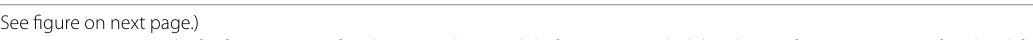
figure on next Fig. 4 Estimation results for four stages. Left column: median model of posterior probability density functions (PDFs) of each subfault. Inserted values indicate the Mw and variance reduction (VR) of the median model. Black and white vectors indicate inputted and calculated horizontal displacements. Right column: 95% confidence intervals (CI) of posterior PDFs of each subfault, as calculated from the difference between the samples located at 2.5% and